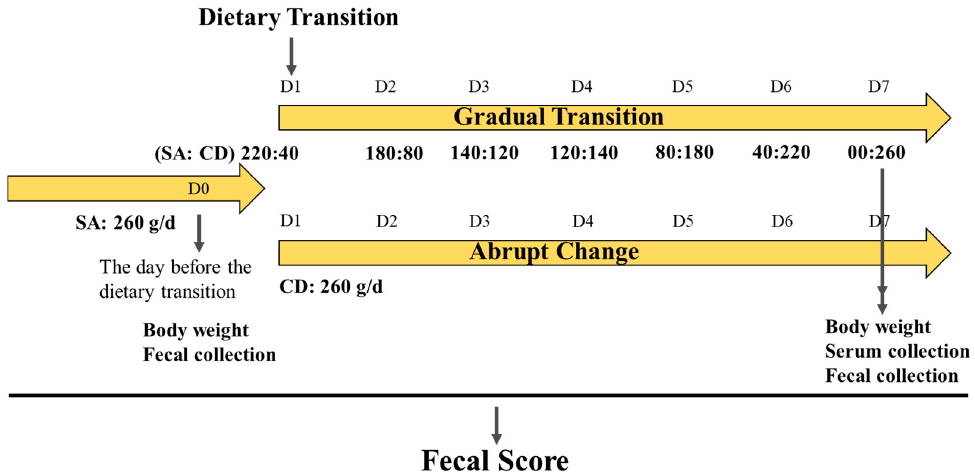
Figure 1. Experiment design and timeline. Beagle puppies were housed individually in metabolic cage. Body weight data and feces samples were collected on D0 and D7. Serum samples were obtained on D7. SA: salmon-based extruded diet; CD: chicken- and duck-based extruded diet. D0: the first day before the dietary transition; D1: the first day of the dietary transition; D7: the seventh day of the dietary transition. Table 1. The chemical and energy compositions of SA and CD diets.